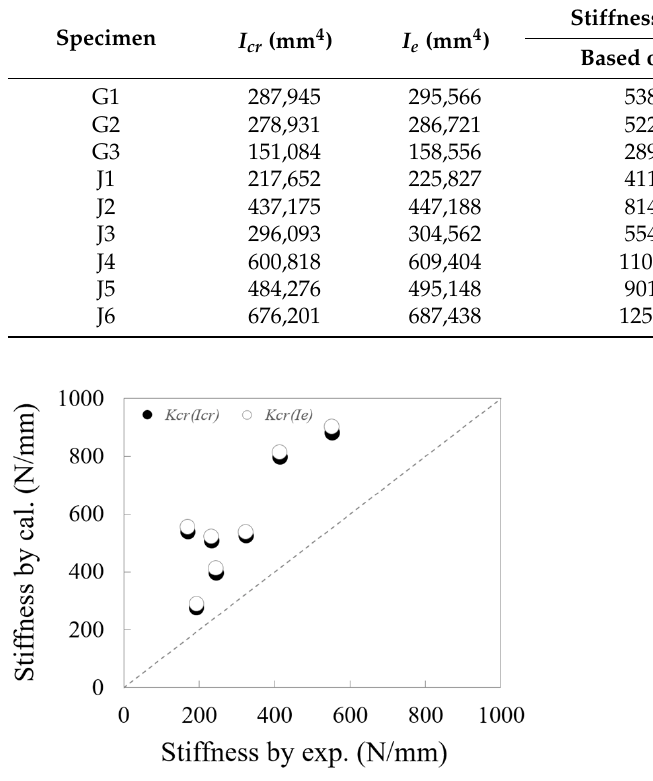
Figure 17. Stiffness ratios for experimental and calculation results.